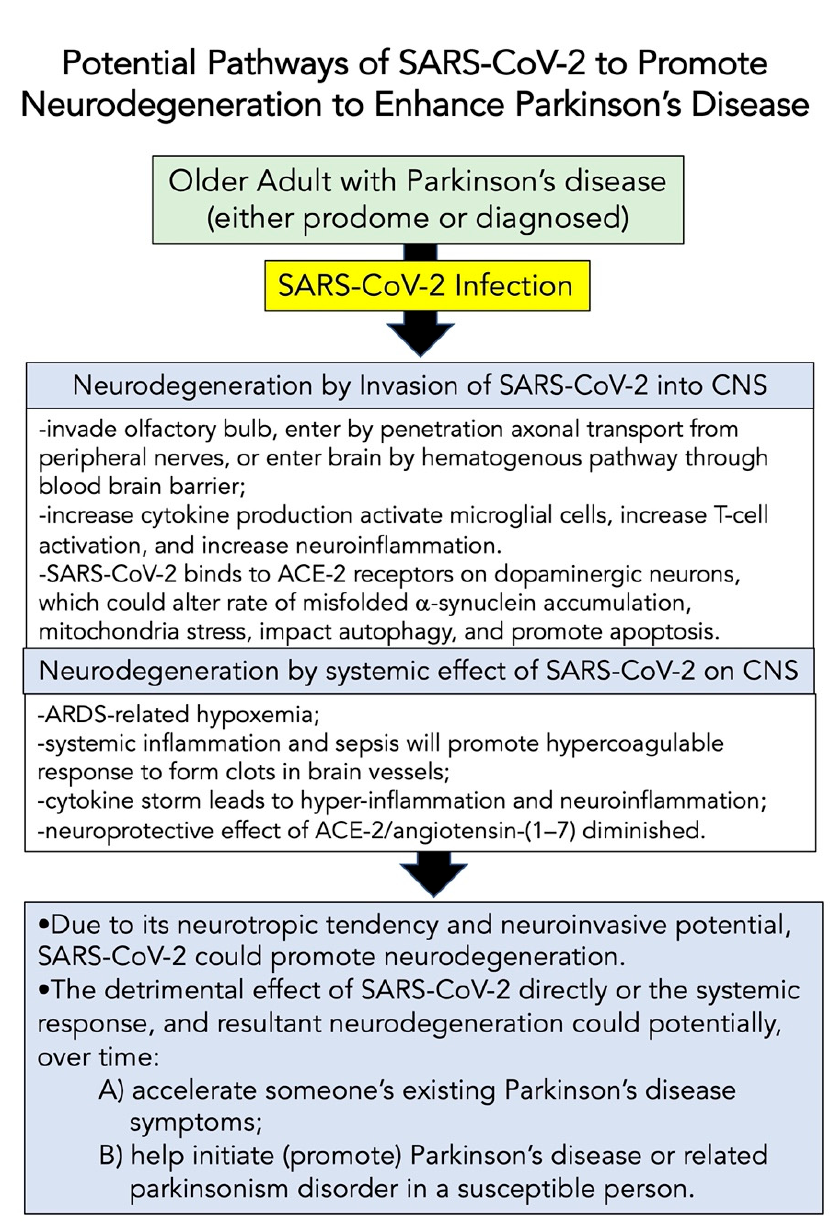
Figure 4. Potential pathways for SARS-CoV-2 to promote neurodegeneration, Parkinson’s disease, or related disorders.